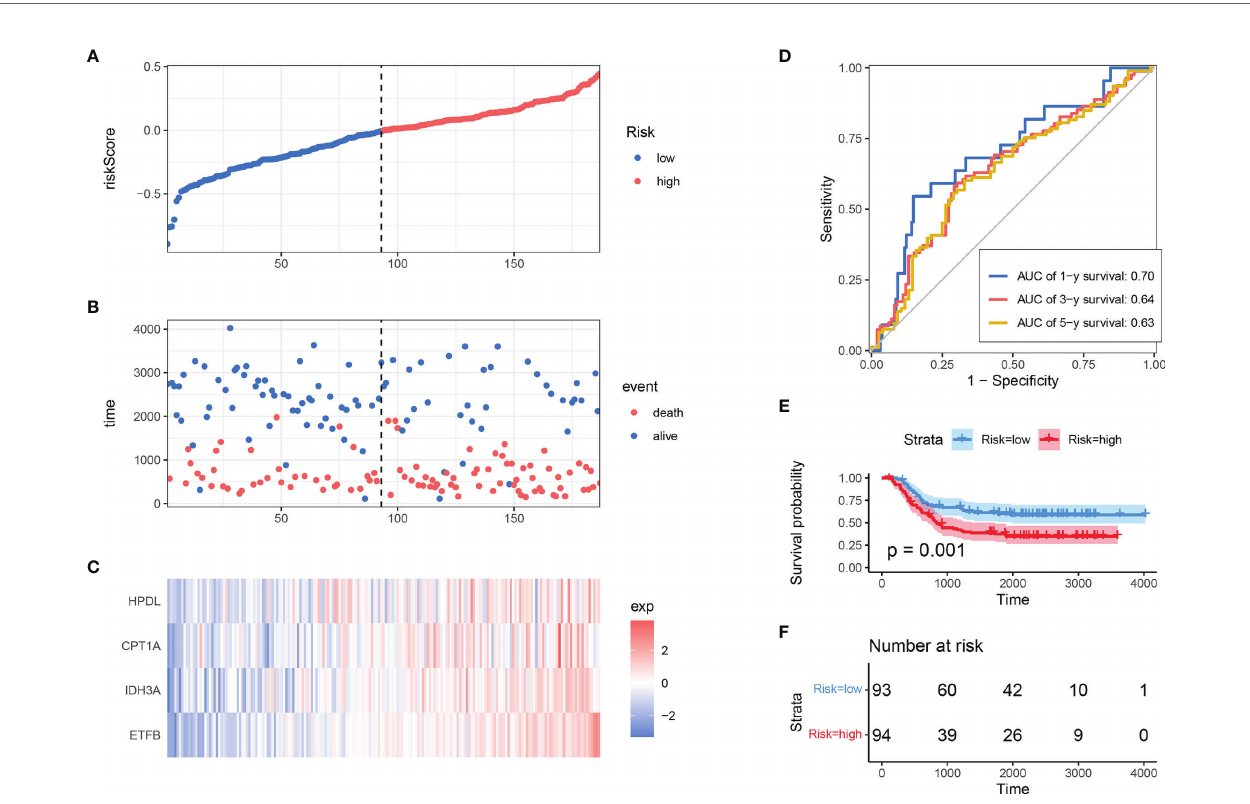
FIGURE 3 | Validation of MRG-based prognostic classi fi er. (A – C) Distribution of risk score, survival status, and expression of 4 MRGs along with risk score in TARGET-AML cohort. (D) ROC curve of 4 MRGs ’ signature classi fi cation in TARGET-AML cohort. (E, F) Survival curves between two risk groups based on 4 MRGs ’ signature classi fi cation in TARGET-AML cohort. MRG, mitochondria-related gene; ROC, receiver operating